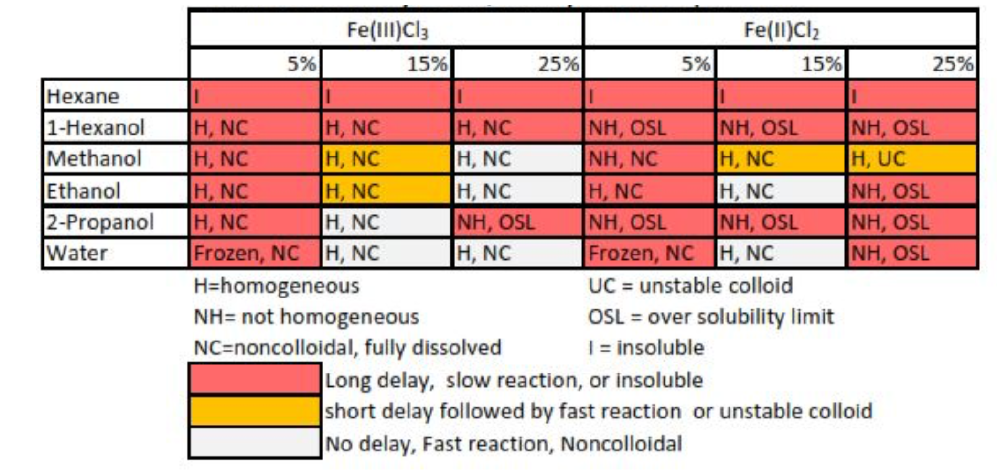
Table 2. A table of observed solubility and reaction characteristics of experimental solutions. Solutions in white cells show high levels of solubility and reaction performance and are promising mixtures for further